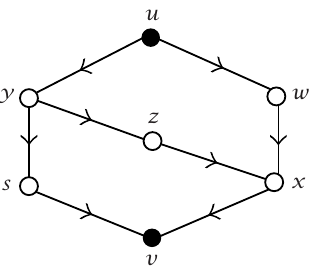
Figure 1.1 . An oriented graph D with h(D) = 2 and g(D) =